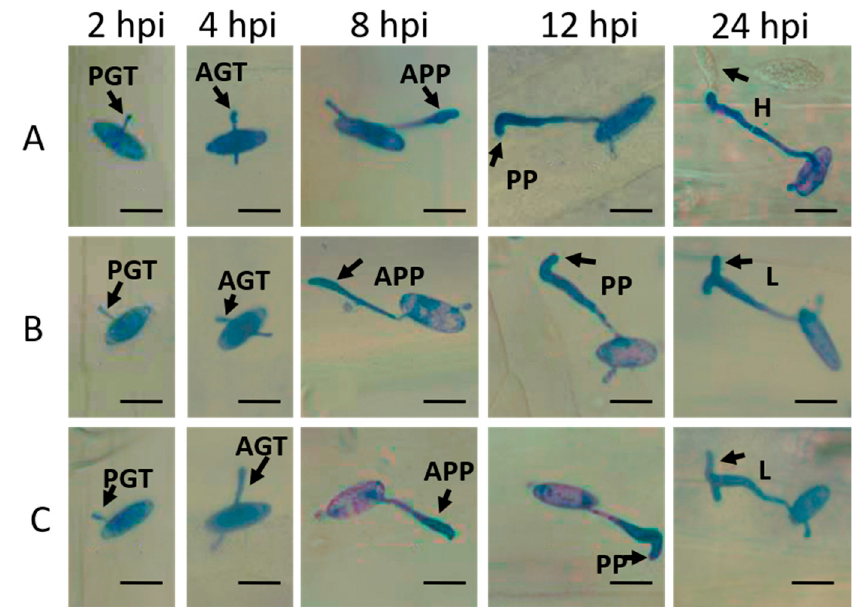
Figure 2. Microscopic observations of wheat- Bgt interactions on the leaf surface . The development of Bgt at 2, 4, 8, 12, and 24 hpi in wheat cultivars Chuannong26 ( A ), L699 ( B ), and Neimai836 ( C ). PGT: primary germ tube, AGT: appressorium germ tube, APP: appressorium, PP: penetration peg, H: haustorium and L: lobe. Scale bar: 20 μ m.